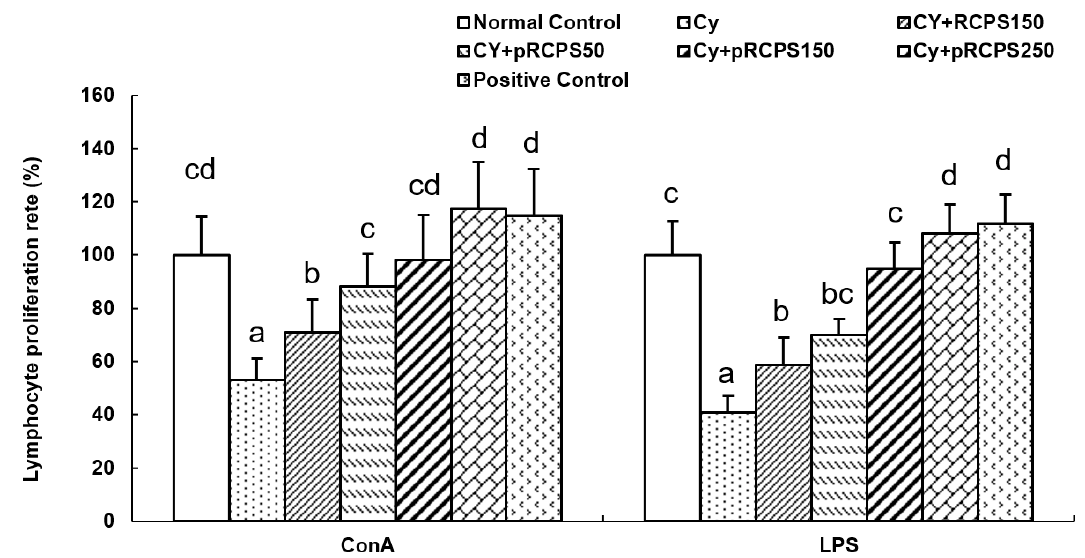
Figure 3. pRCPS affects the proliferation of lymphocyte in Cy-immunosuppressed mice. Cy-immunosuppressed mice were orally treated with pRCPS solution (equivalent to 50, 150, and 250 mg of pRCPS/mouse/day) for 18 days. 24 h after the last dose, splenocytes were extracted and cultured with ConA (5 µg/mL), or RPMI-1640 (control) for 68 h. The cytokine (IL-4 and IFN- γ ) concentration of supernatants of splenocyte was measured by ELISA. Data represent the mean ± SD ( n = 7). Bars marked with different letters (a–d) indicate differences that are statistically significant ( P < 0.05).